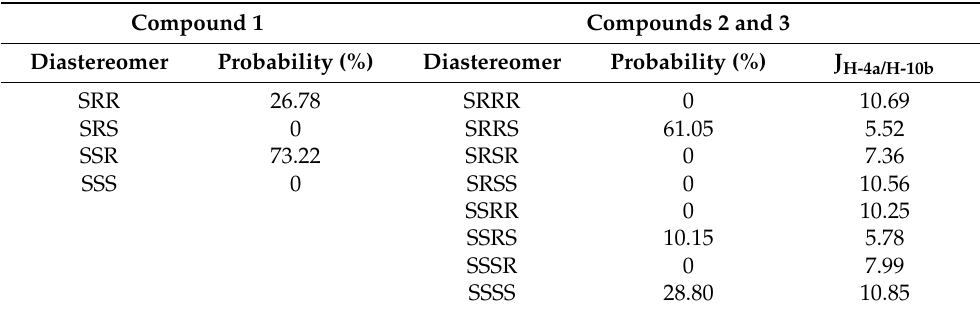
Table 2. DP4+ probabilities of compounds 1 – 3 and computed J -couplings of compounds 2 and 3 estimated using CD 3 OD as solvation model. For compound 1, stereocenters’ order is (4a,3,10b). For compounds 2 and 3 , stereocenters’ order is